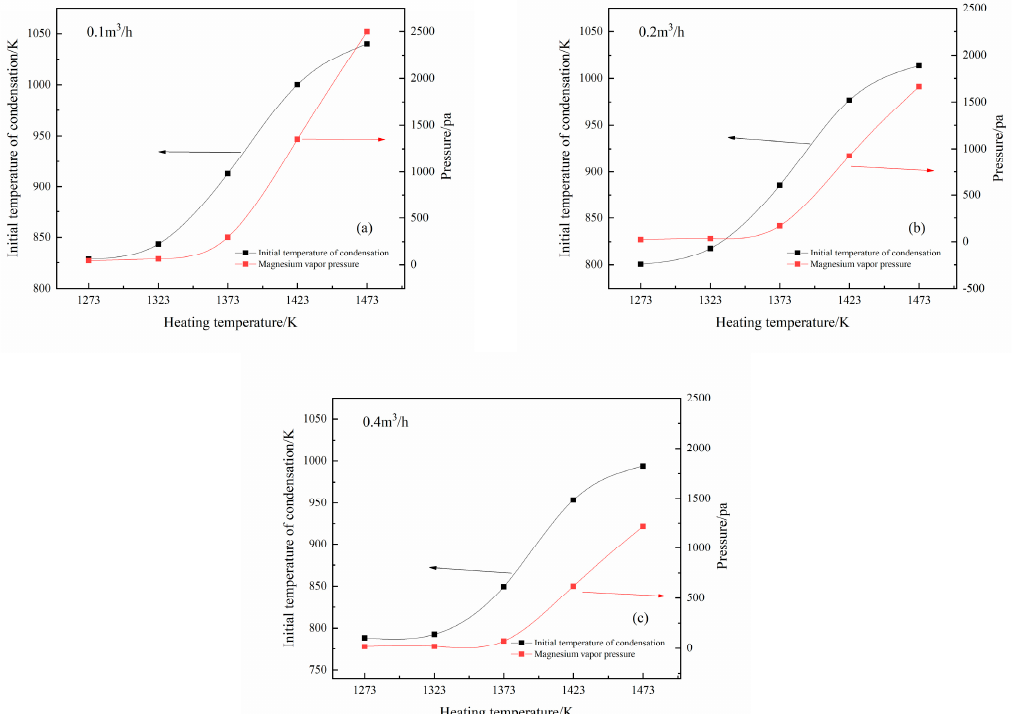
Figure 5. E ff ects of temperature and Ar flow on condensation temperature and vapor pressure at condensation point: ( a ) 1273–1473 K heating and 0.1 m 3 / h Ar, ( b ) 1273–1473 K heating, 0.2 m 3 / h Ar, ( c ) 1273–1473 K heating and 0.4 m 3 / h